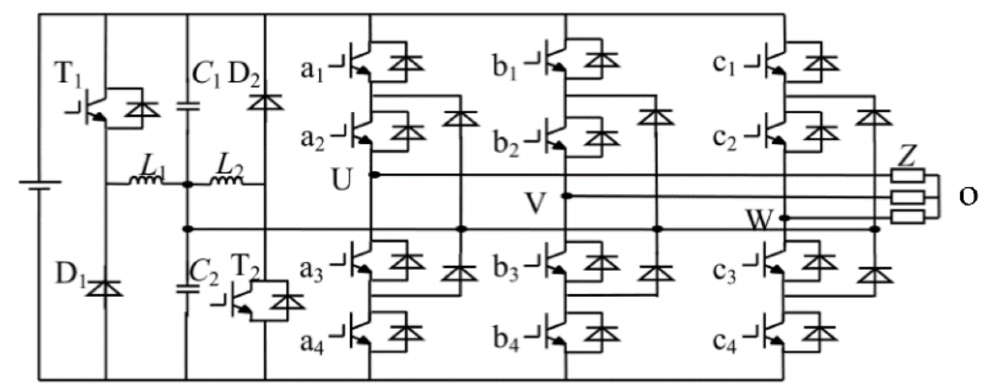
Figure 2. Main circuit of a diode-clamped three-level